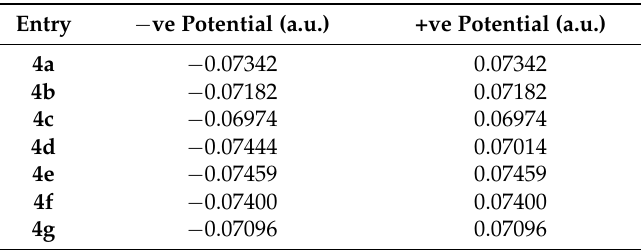
Table 3. Values of ´ ve and +ve potential of products 4a – g , computed at the DFT/B3LYP/6-31G (d, p)